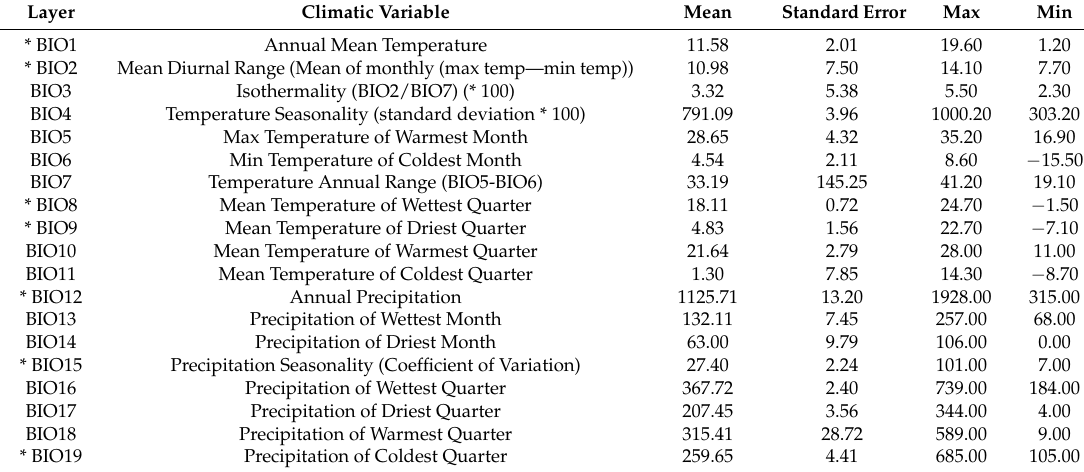
Table 1. Environmental variables at occurrence points used in the model with final selected variables after checking for cross correlation. Layer Climatic